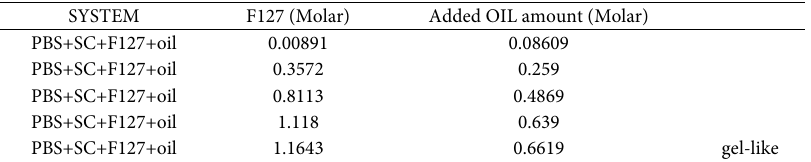
Table 3. Titration of turbid solution of F127, SC, oil in PBS with Ethyl butyrate oil and F127 surfactant ( [Sodium Caprylate (SC)]= 2.641 M) with aim determining region of turbid and clear